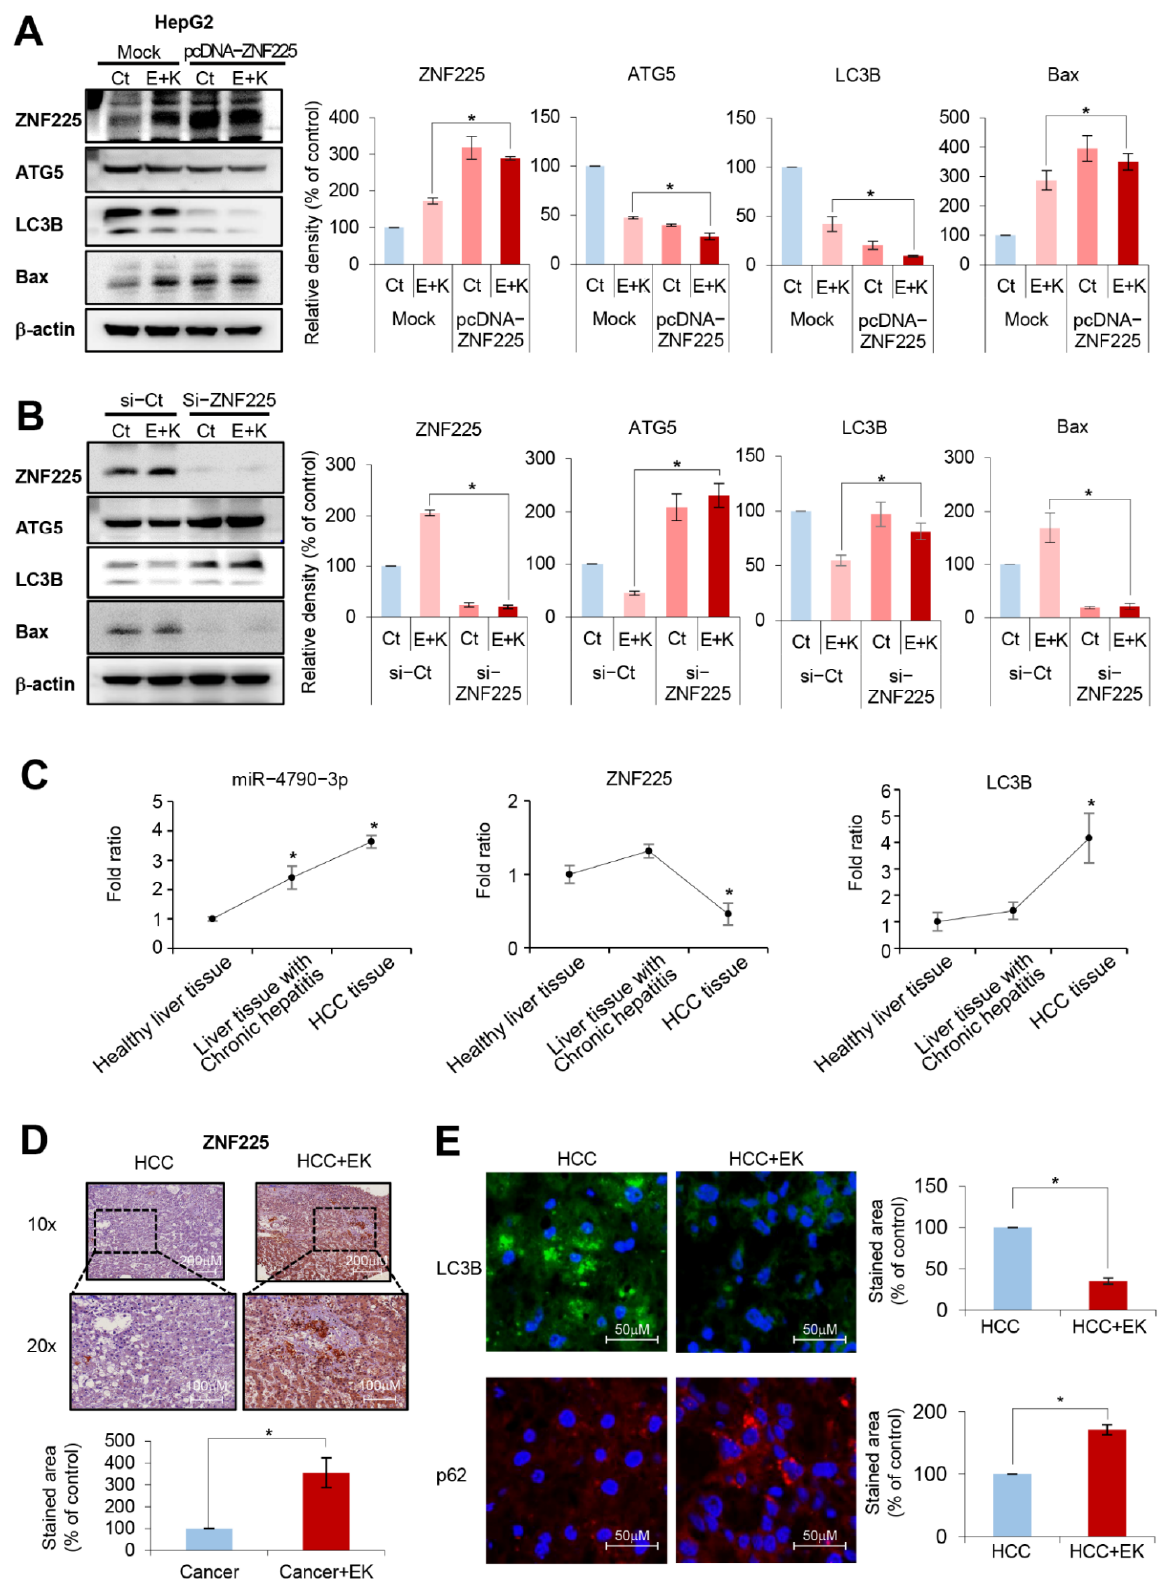
Figure 5. Determining the expression of miR-4790-3p and Zinc finger protein 225 (ZNF225) ( A ) Western blot analysis showing the effects of overexpressing ZNF225 on the expression of markers related to apoptosis and autophagy, respectively, in HepG2 cells. ( B ) Western blot analysis showing the effects of suppressing ZNF225 on the expression of markers